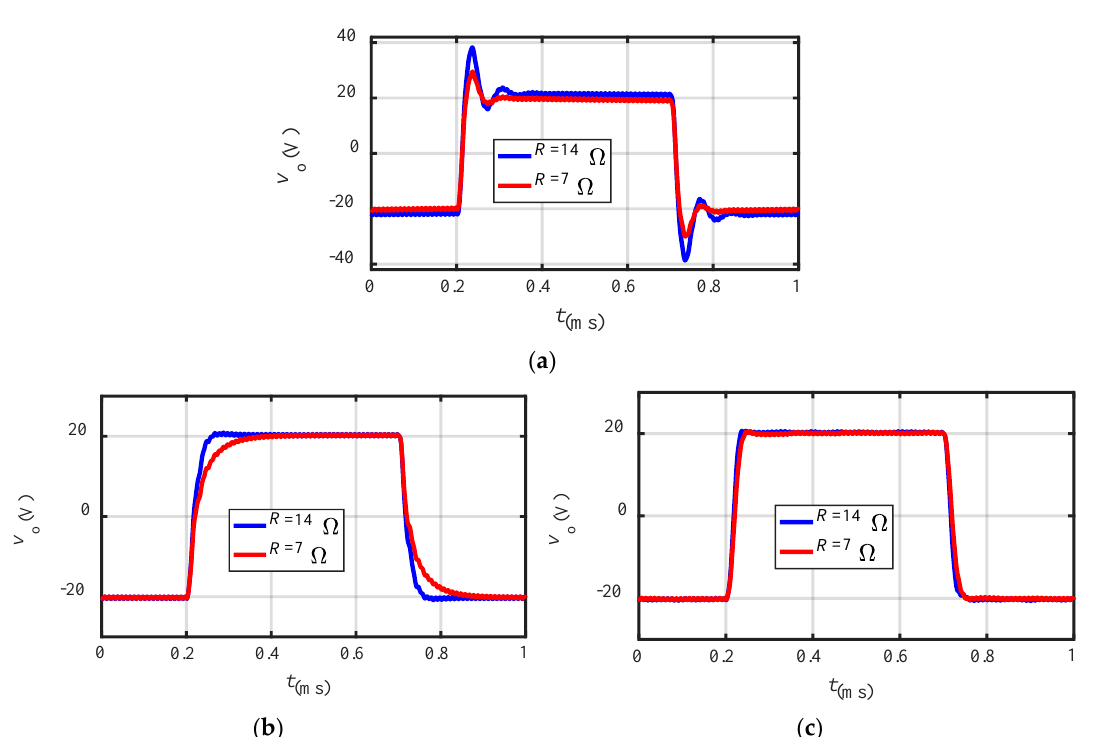
Figure 9. Simulation-based transient response of ( a ) open-loop GaN class-D amplifier; ( b ) FFDISM controller using inductor current; ( c ) FFDISM controller using capacitor current.